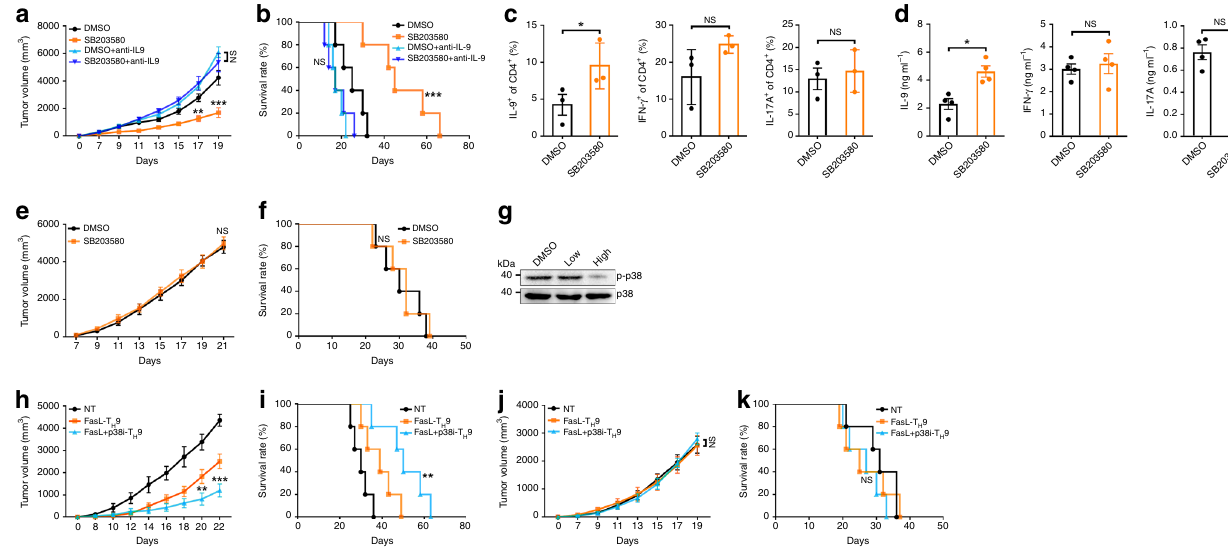
Fig. 7 p38 inhibitor exerts antitumor activity by inducing T helper type 9 (T H 9) cells. a , b Tumor growth ( a ) and survival ( b ) of wild-type (WT) mice that received a subcutaneous injection of LLC-OVA cells followed by an intraperitoneal injection of SB203580 (0.5 mg kg − 1 ) with or without an intravenous injection of 100 µ g of anti-IL-9-neutralizing antibodies every other day ( n = 5). c Flow cytometric analysis of the frequencies of IL-9 + (interleukin-9 + ), IFN- γ + , and IL-17A + cells among CD4 + T cells in the TILs of the mice described in a 20 days after tumor inoculation ( n = 2 – 3). d Enzyme-linked immunosorbent assay (ELISA) measurements of IL-9, IFN- γ , and IL-17A levels secreted by OVA 323 – 339 -stimulated TILs from the mice described in a 20 days after tumor inoculation ( n = 3). e , f Tumor growth ( e ) and survival ( f ) of Fas lpr → WT mice that received a subcutaneous injection of LLC-OVA cells followed by an intraperitoneal injection of SB203580 (0.5 mg kg − 1 ) every other day ( n = 5). g Western blotting analysis of p-p38 expression in colonic tissues from mice that received intraperitoneal injection of low- (0.5 mg kg − 1 ) or high-dose (10 mg kg − 1 ) SB203580 every other day for a total of 11 injections. h – k Tumor growth ( h ) and survival ( i ) of WT mice or tumor growth ( j ) and survival ( k ) of Il9r − / − mice that received a subcutaneous injection of B16F10-OVA cells followed by no transfer (NT) or intravenous injection of 2 × 10 6 OT-II FasL-T H 9 or FasL + p38i-T H 9 1 and 6 days later ( n = 5). NS, not signi fi cant; * P < 0.05, ** P < 0.01, and *** P < 0.001 (unpaired Student ’ s t test: a , c – e , h , j ; log-rank test: b , f , i , k ). Compared with dimethyl sulfoxide